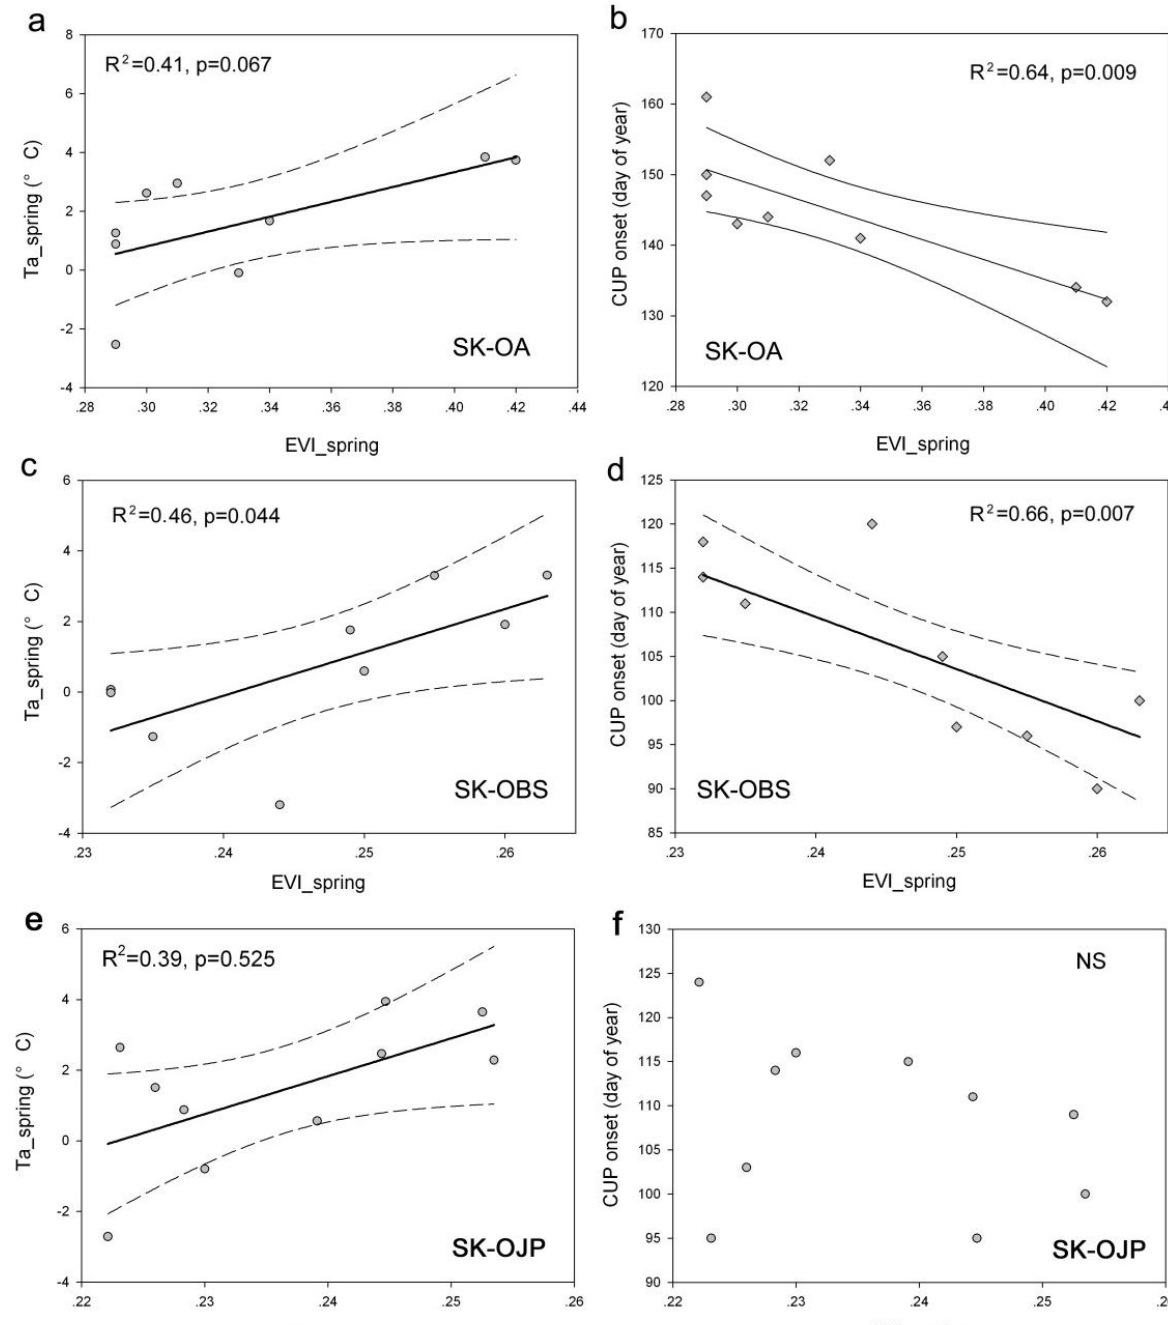
single-day changes in CUP onset, with annual GPP changing at rates of 2.9 (y = −2.9x + 1093.7) and 2.6 g∙C∙m −2 ∙y −1 (y = −2.6x + 859.3) for SK-OBS and SK-OJP, respectively. Figure 3. Relationships between spring EVI and ( a ) spring temperature (Ta_spring) for SK-OA, ( b ) carbon-uptake period (CUP) onset for SK-OA, ( c ) spring temperature (Ta_spring) SK-OBS, ( d ) CUP onset for SK-OBS, ( e ) spring temperature (Ta_spring) SK-OJP, and ( f ) CUP onset for SK-OJP. NS indicates no significant correlation. The solid and dashed lines represent regression and its 95% confidence of mean